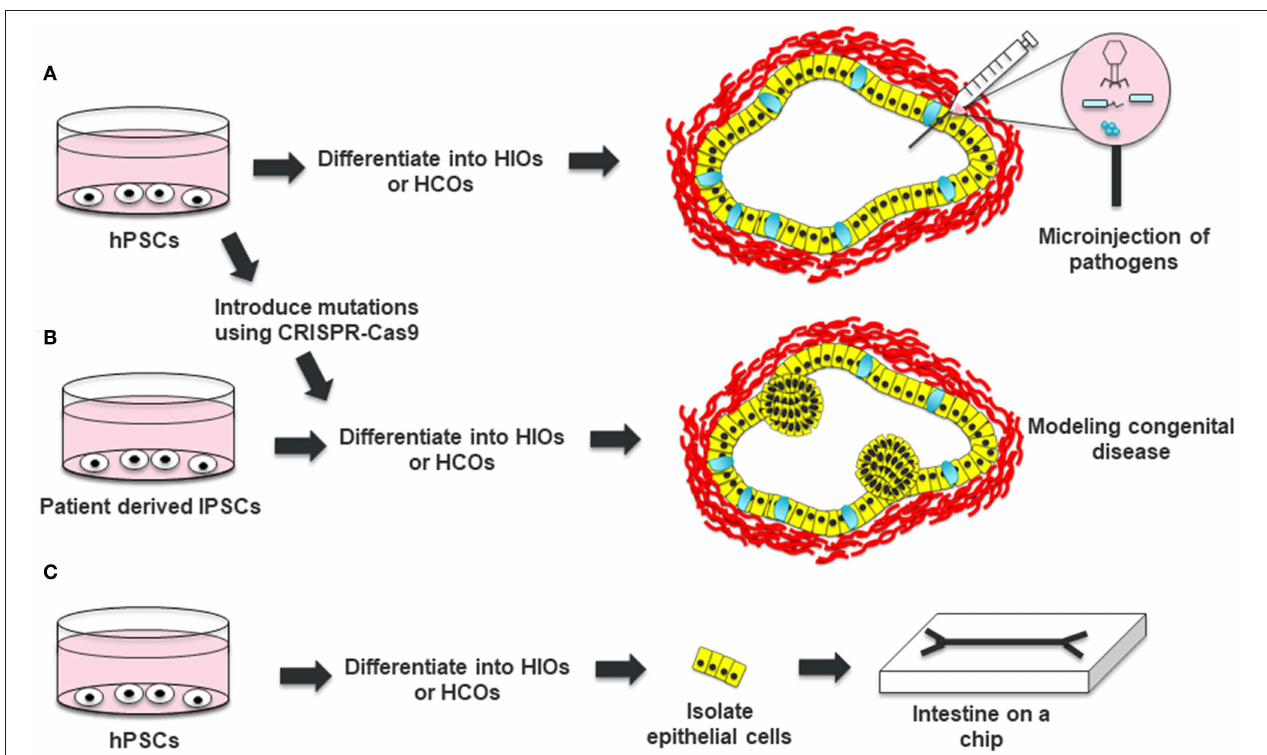
FIGURE 2 | Applications of HIOs and HCOs. (A) Human pluripotent stem cells can be differentiated into HIOs or HCOs and microinjected with bacterial or viruses to study host-pathogen interaction. (B) Induced pluripotent stem cells from patients with a congenital disease or hPSCs which are edited to carry a pathogenic mutation can be differentiated into HIOs and used to model the disease. (C) Epithelial cells from generated HIOs can be isolated and then placed in a microchip to test the effects of luminal flow and luminal contents on epithelial physiology. Definitive endoderm derived epithelia are depicted in yellow. Mesoderm derived cells are depicted in red. Goblet cells within HCOs are depicted in